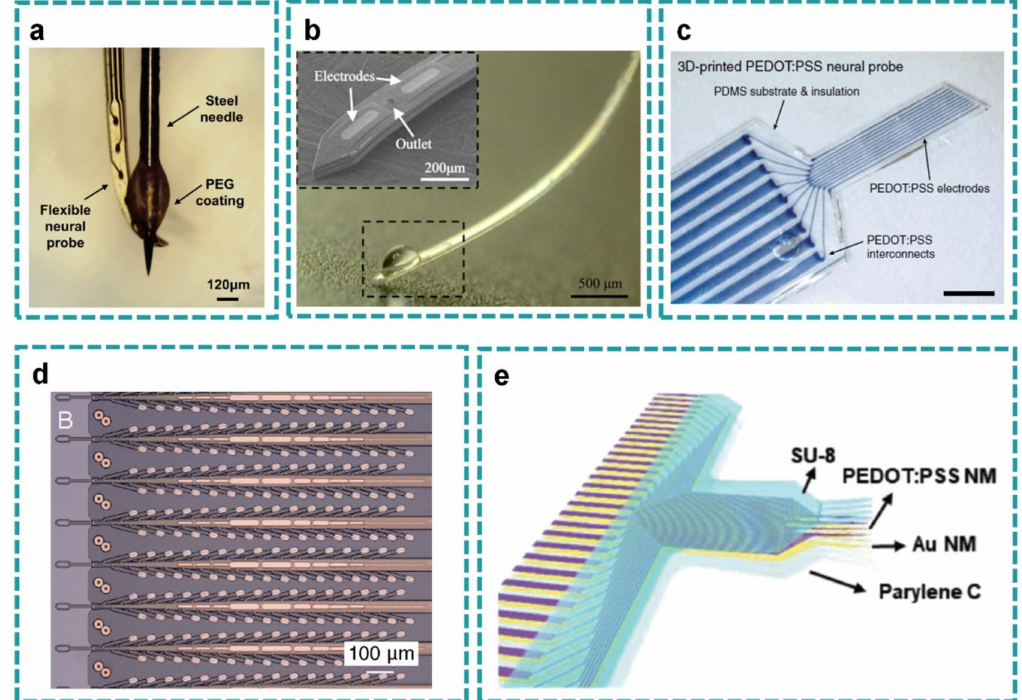
Figure 4. Probe layout. ( a ) a flexible neural probe with the simple but robust mobile insertion shuttle consisting of a steel needle with a dissolvable spheroid micropost (reprinted with permission from [97]); ( b ) the PDMS-based probe with embedded Gallium (Ga) could be adjusted by five orders of magnitude before and after the insertion into the targeted brain region (reprinted with permission from [81]); ( c ) a high-performance 3D printed probe fabricated by the printable conducting polymer ink; scale bar, 1mm (reprinted with permission from [77]); ( d ) the arrays of small and flexible electrode “threads” with up to 3072 electrodes (reprinted with permission from [49]); ( e ) a penetrating microelectrode probes in array focusing on light transmittance (reprinted with permission from